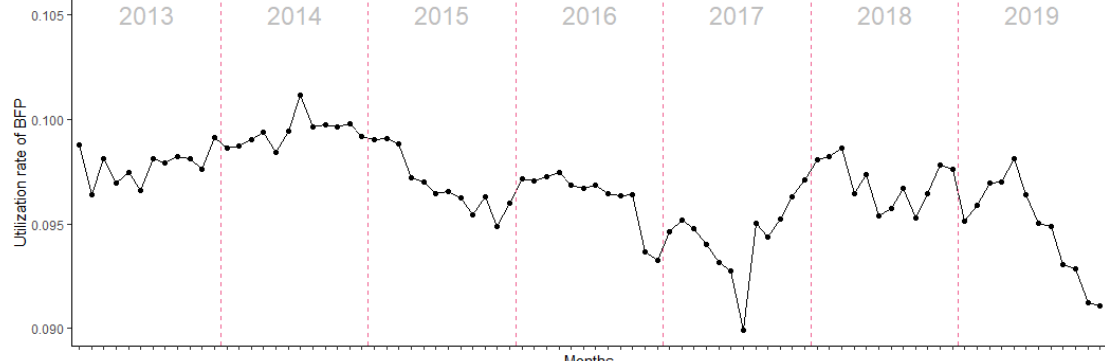
Figure 2. General utilization rate of BFP over the months. Source: prepared by the authors.